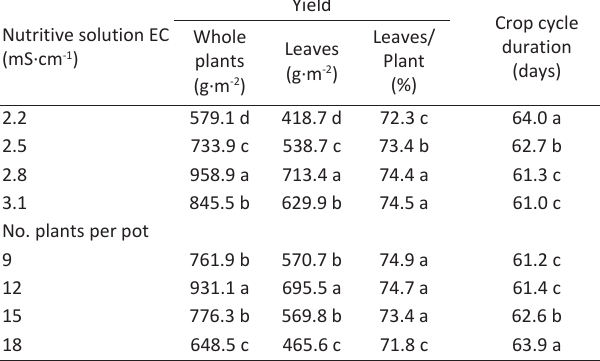
Table 2 - Basil yield results